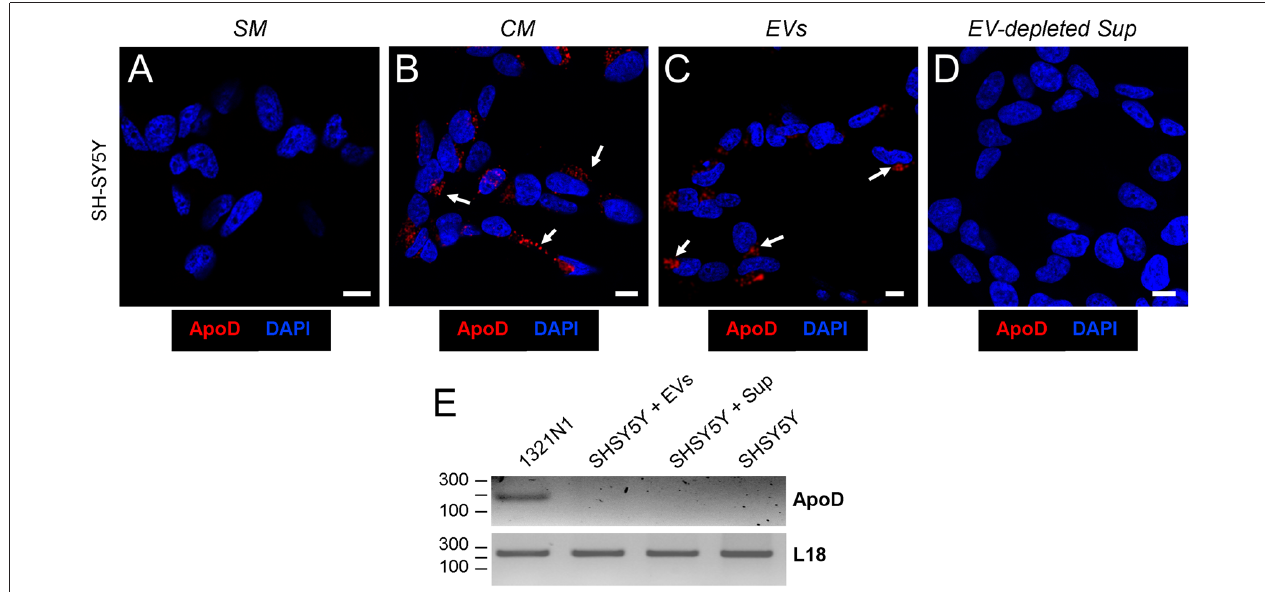
FIGURE 3 | Astrocyte-to-neuron ApoD traffic is exclusively mediated by EVs. (A–D) Single plane confocal microscopy images extracted from Z-stacks obtained from SH-SY5Y cells cultured with standard medium (SM; A ), astrocyte-conditioned medium (CM; B ), purified astrocyte EVs (C) , or EV-depleted astrocyte-derived supernatant, Sup (D) . Arrows point to the ApoD vesicular labeling within SH-SY5Y neurons. No signal is detected when SM or EV-depleted Sup is used. Calibration bars: 10 µ m. (E) RT-PCR analysis of ApoD mRNA expression in the1321N1 donor cells, and in SH-SY5Y differentiated neurons after 48 h exposure to 1321N1-generated EVs. The housekeeping ribosomal gene RPL18 is amplified as